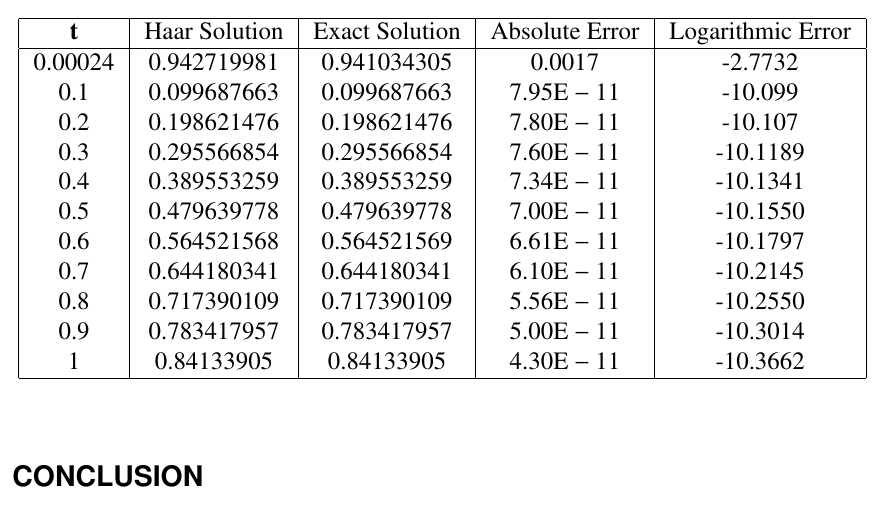
Table 3 represents the numerical solutions and exact solution at selected values of x for J = 6. Absolute error or the numerical solutions are also represented in the tables at the last column. To be able to compare the e ff ect of J , one can use Table 3 and Table 4 which represents solutions for J = 10. Table 4. Numerical results and exact solutions for Example 2 for J =